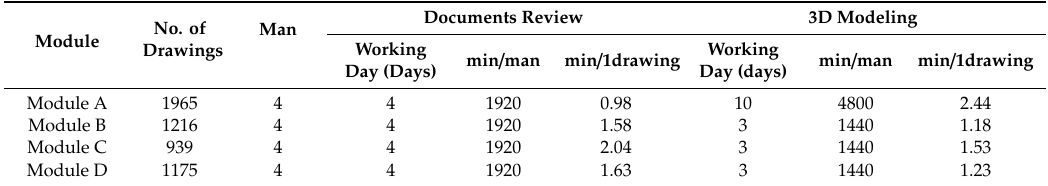
Table 5. Productivity analysis of documentations review and 3D